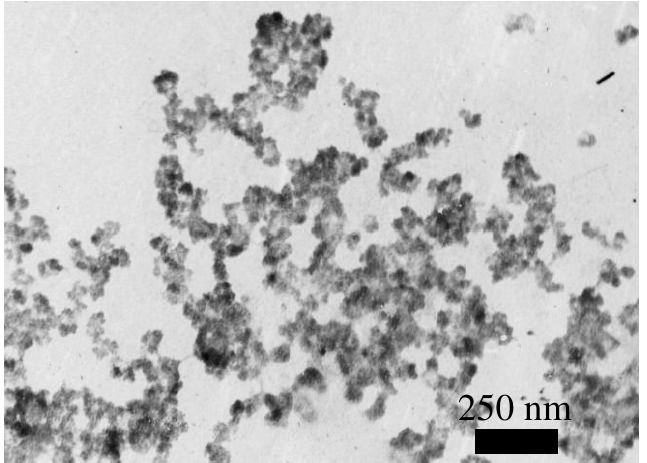
Figure 2. TEM image of SnO 2 particles of powder obtained by the SnCl 4 hydrolysis methods.